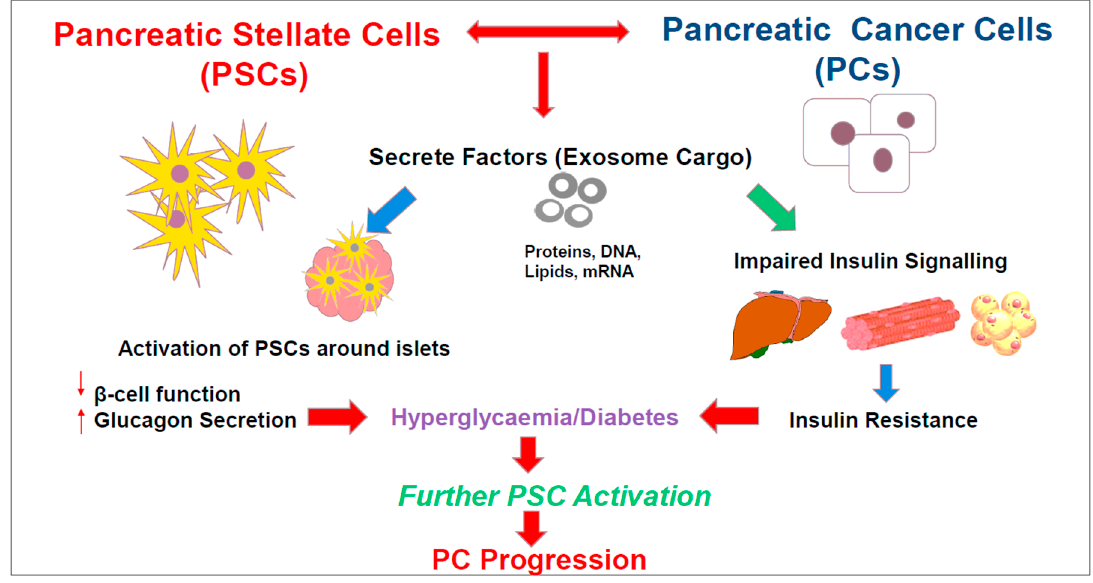
Figure 3. The figure depicts the concept that pancreatic stellate cells and cancer cells (including PanINs) secrete factors that are carried by exosomes to (i) activate PSCs in and around islets causing islet cell dysfunction and (ii) impair the insulin signalling pathway in hepatocytes, adipocytes and skeletal myocytes leading to insulin resistance. These effects cause hyperglycaemia/diabetes in the early asymptomatic stage of PDAC. Hyperglycaemia can lead to further PSC activation, which in turn drives accelerated PDAC progression.